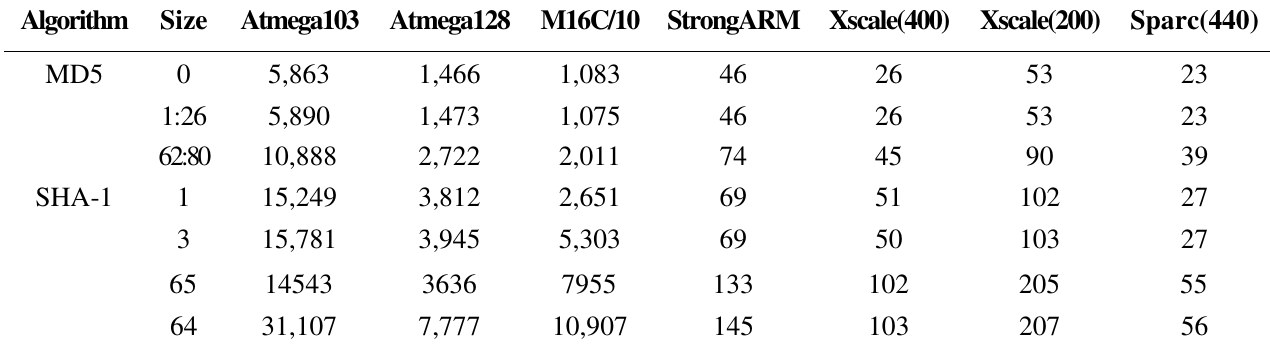
Table 2. Execution times [ µ s ] for two different hash algorithms, platforms and plaintext sizes